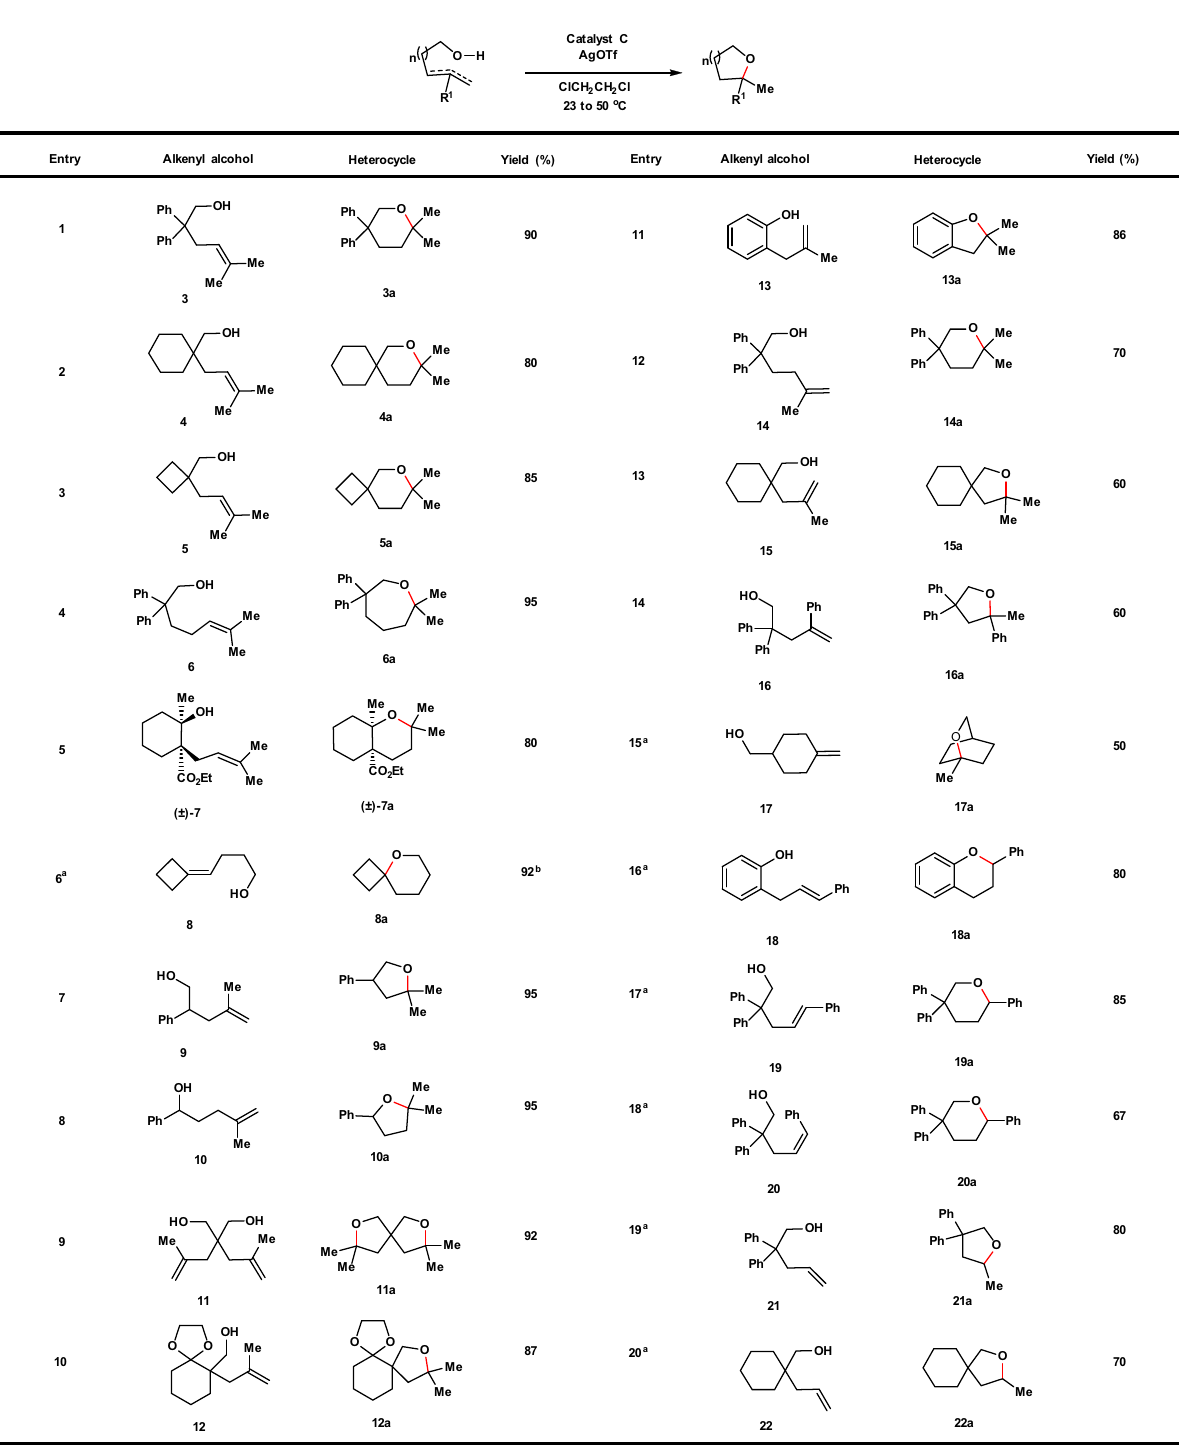
Fig. 3 Substrate scope for intramolecular hydroalkoxylation. General conditions: Catalyst C (1 mol%), AgOTf (2 mol%), ClCH 2 CH 2 Cl, 23 °C, 24 h. Yields of isolated products are given. a Catalyst C (2 mol%), AgOTf (4 mol%), ClCH 2 CH 2 Cl, 50 °C, 48 h. Yields of isolated products are given. b Determined by 1 H NMR analysis using 4,4'-di- tert -butyl-1,1'-biphenyl as an internal